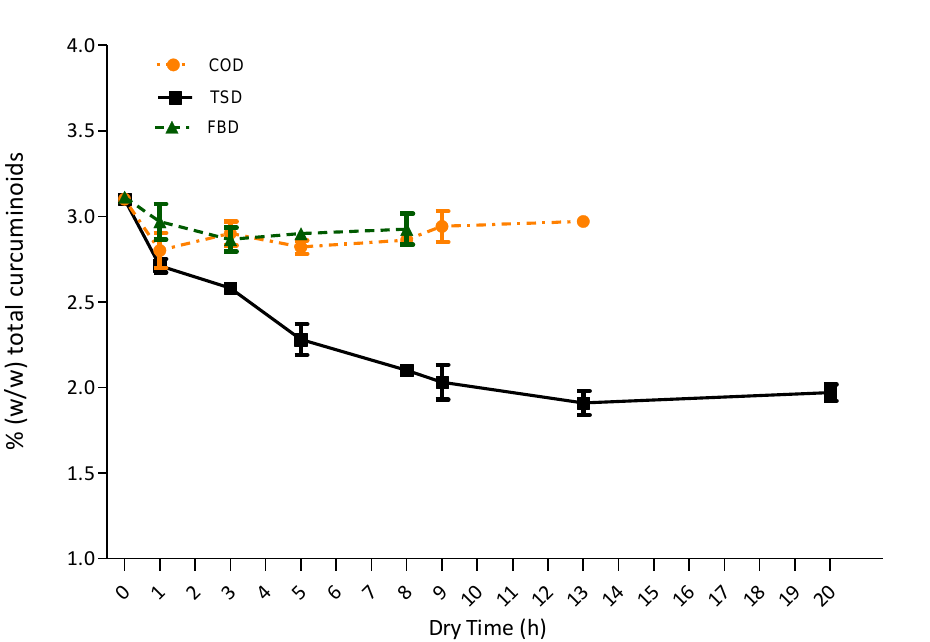
Figure 1. Degradation kinetics plot of total curcuminoids content, for convection oven drying (COD), solar drying (TSD), and fluidized bed drying (FBD).